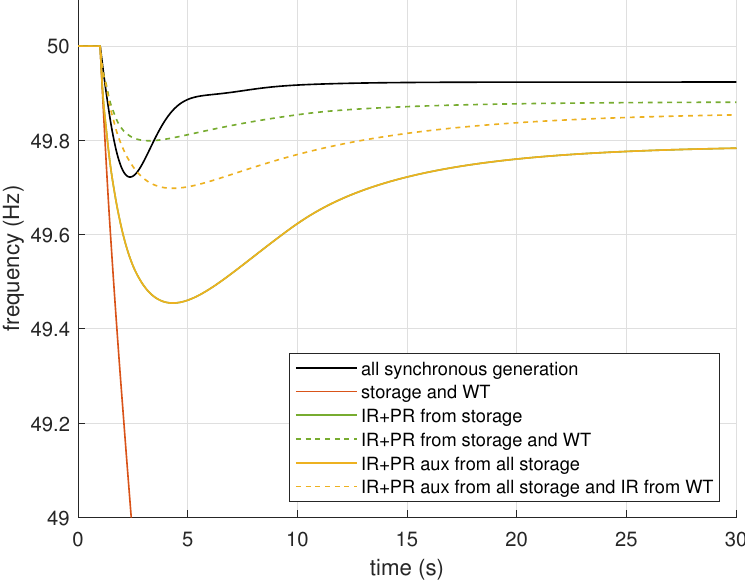
Figure 14. Results of scenario HL-LR (high load and low RES